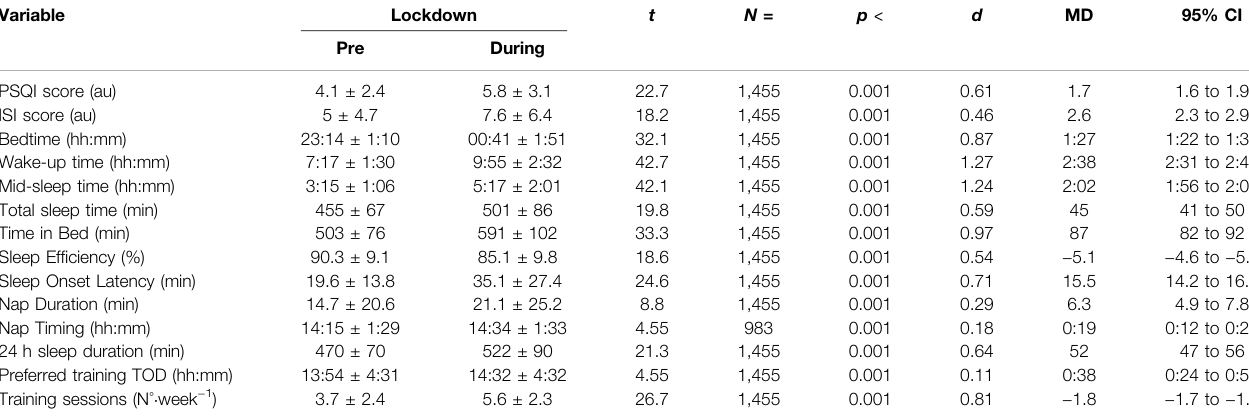
TABLE 1 | Statistical parameters relating to changes in sleep and training behaviors in response to lockdown. Variable